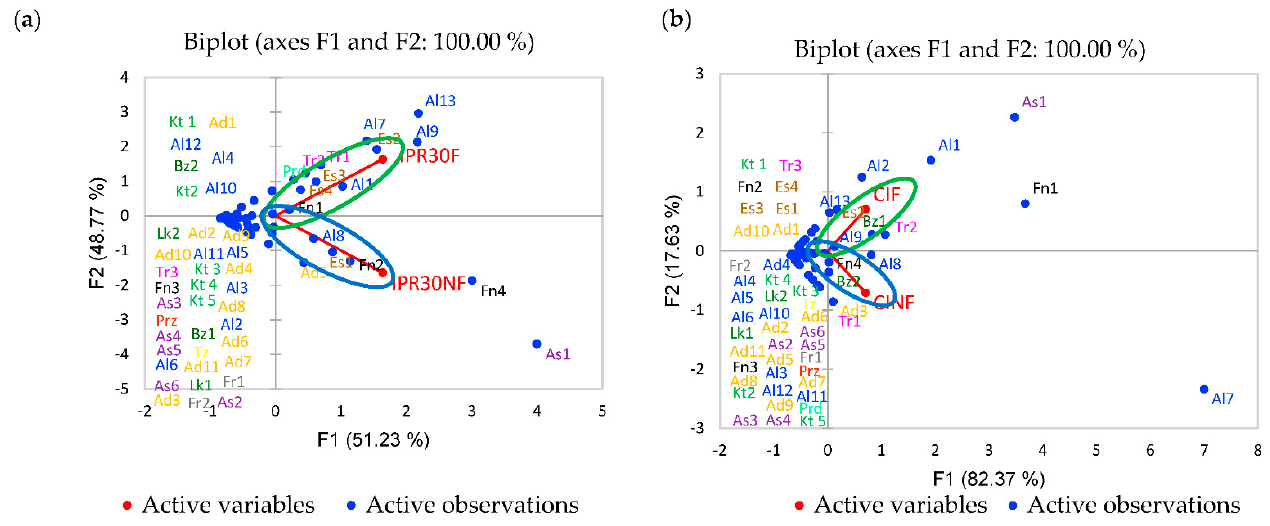
Figure 2. PCA plot of volatile compounds of ( a ) Inpari 30 (IPR30) and ( b ) Cempo Ireng (CI) (F, fermented; NF, non ‐ fer ‐ mented).